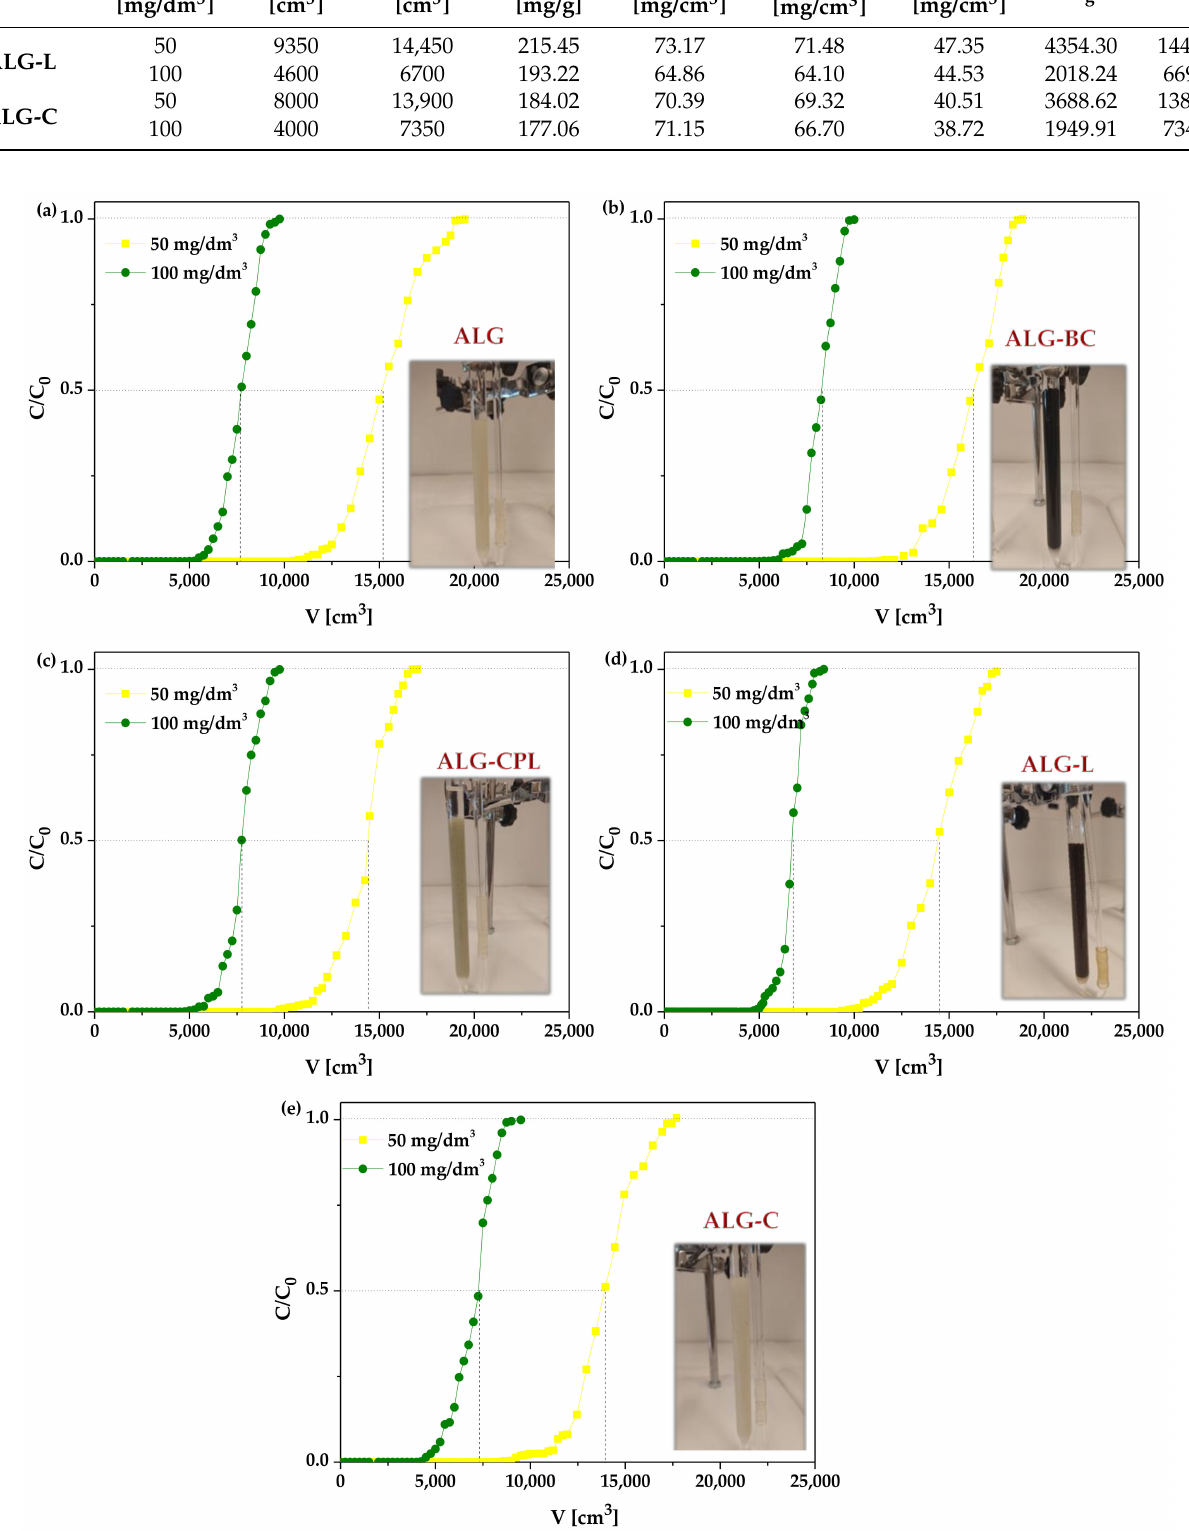
Figure 5. Breakthrough curves of La(III) ions sorption for the alginate-based adsorbents: ( a )